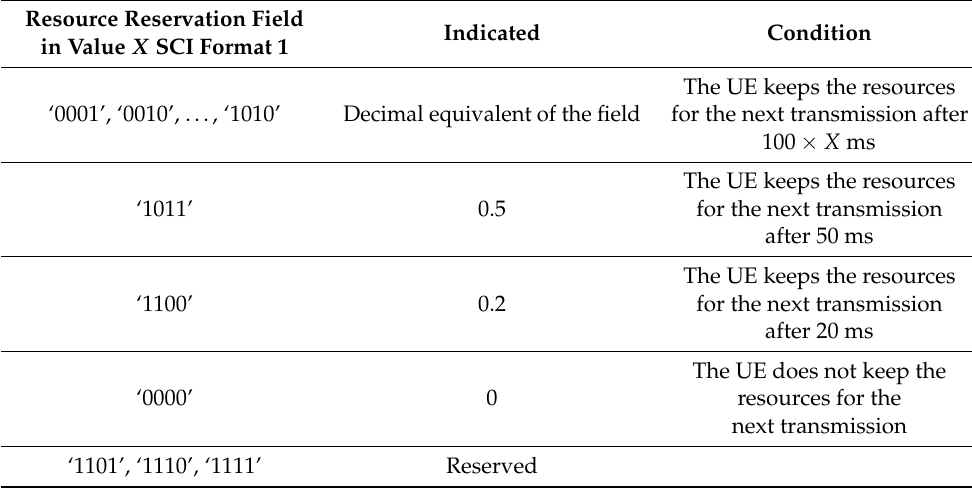
Table 2. Determination of the Resource Reservation field in SCI Format